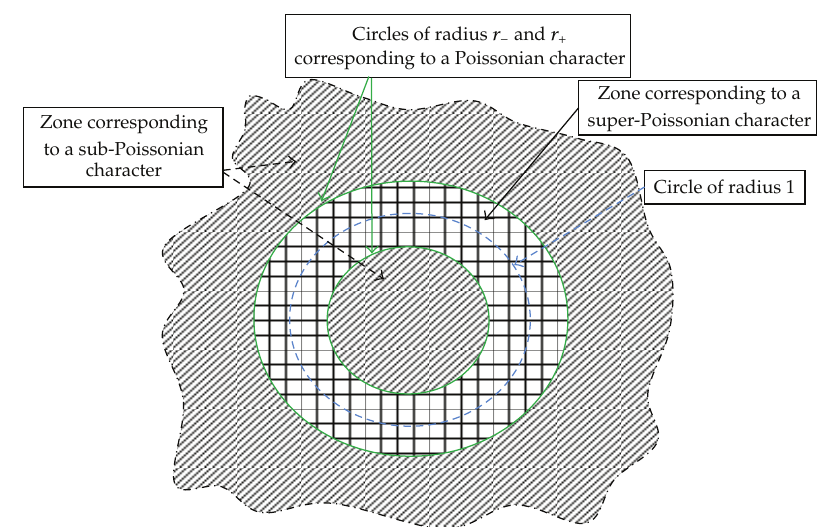
Figure 1: Quantum photon counting